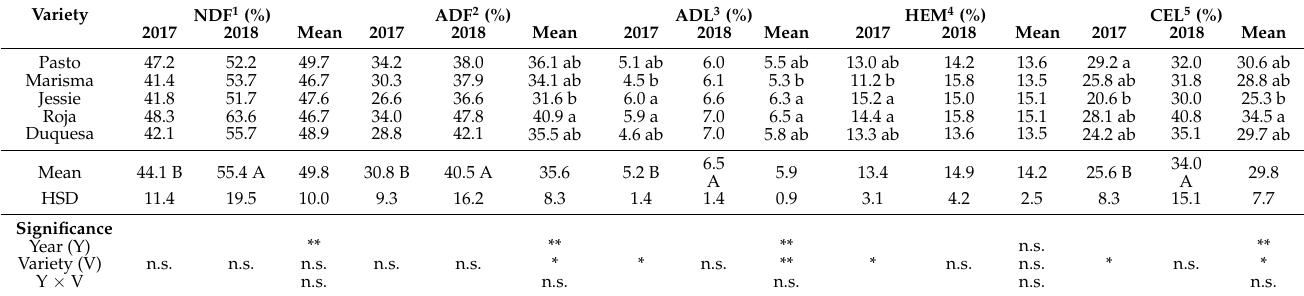
Table 2. Fiber composition of straw of five quinoa varieties during the two years (2017 and 2018) of field experiments. Variety NDF 1 (%)